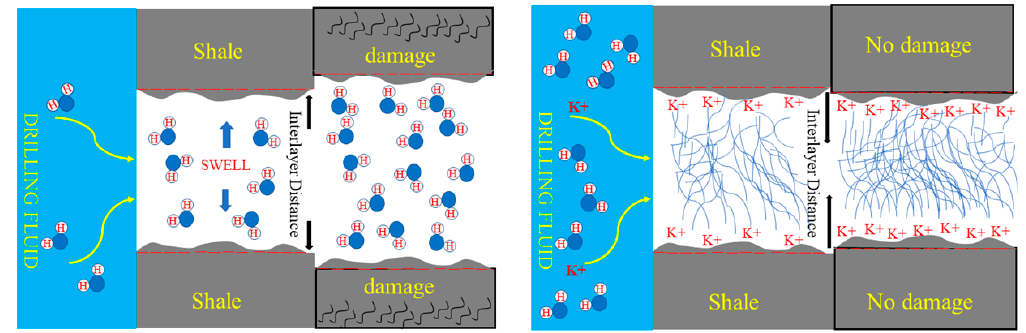
Figure 8. Principle of shale shrinkage due to potassium ion Figure 7. Principle of shale shrinkage due to potassium ion embedding.